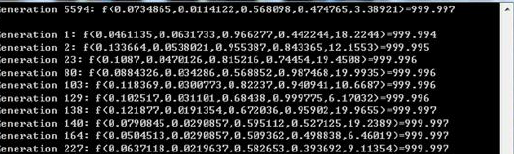
Figure 6 Acceleration efficiencyafter using OpenMP parallel processing